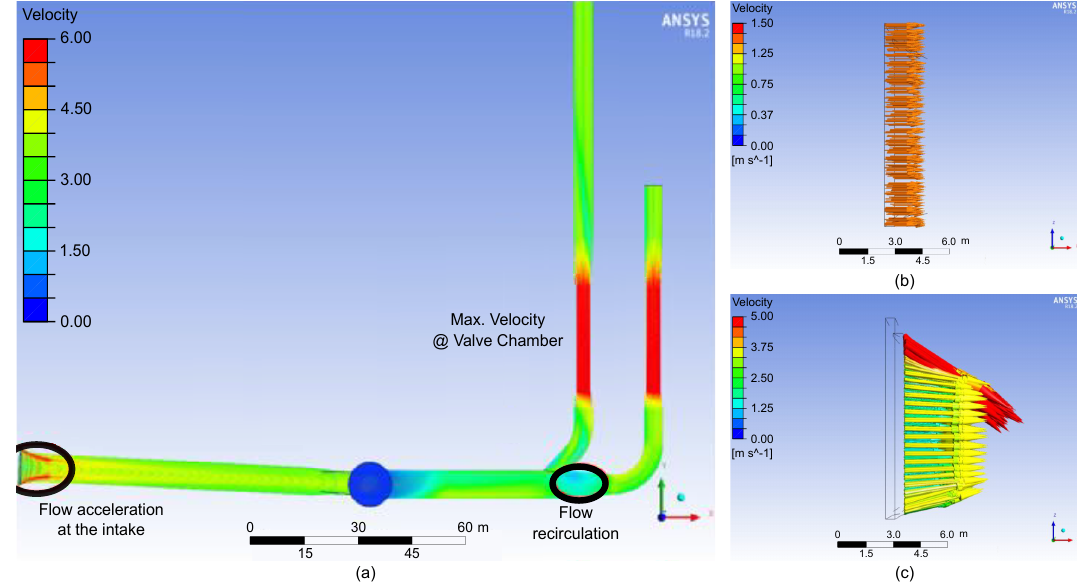
Figure 7. Simulations performed in ANSYS R (cid:13) Fluent R (cid:13) . ( a ) Flow from the new intake to headrace connection. ( b ) Velocity vectors at the input. ( c ) Velocity vectors at the